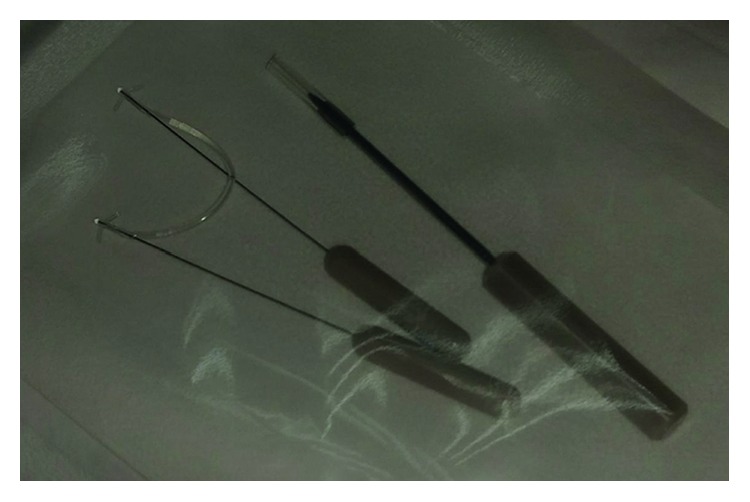
The self-retaining bicanalicular stent.